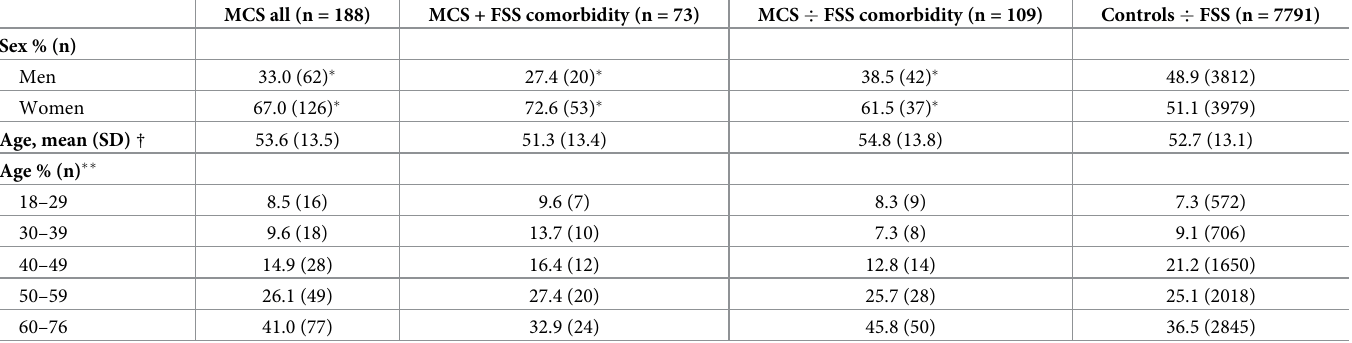
Standard deviation (SD). MCS all: All participants meeting criteria for MCS. MCS + FSS: Participants meeting criteria for MCS and one or more comorbid FSS. MCS � FSS: Participants meeting criteria for MCS but not comorbid FSS.